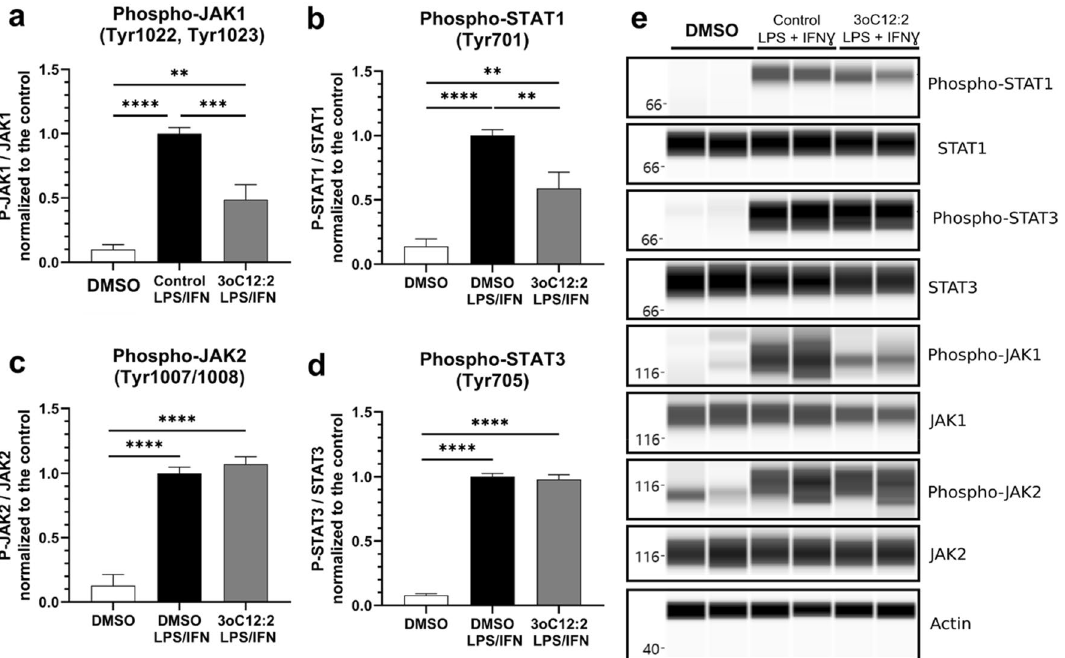
Figure 3. 3-oxo-C12:2-HSL prevents activation of the JAK-STAT pathway. Cells were stimulated with LPS and IFNγ in absence (control) or in presence of 50 µM 3-oxo-C12:2-HSL for 2 h. The levels of phosphorylated proteins P-JAK1 ( a ), STAT1 ( b ), JAK2 ( c ), STAT3 ( d ) were normalized to their respective unphosphorylated forms. Results are expressed as mean ± SEM from 4 independent experiments. One-Way ANOVA, Dunnett’s post-test **p < 0.01, ***p < 0.001, ****p < 0.0001 vs. control. ( e ) Reconstructed images from Simple Western analysis of protein levels and actin used as housekeeping protein are displayed. They are based on the area